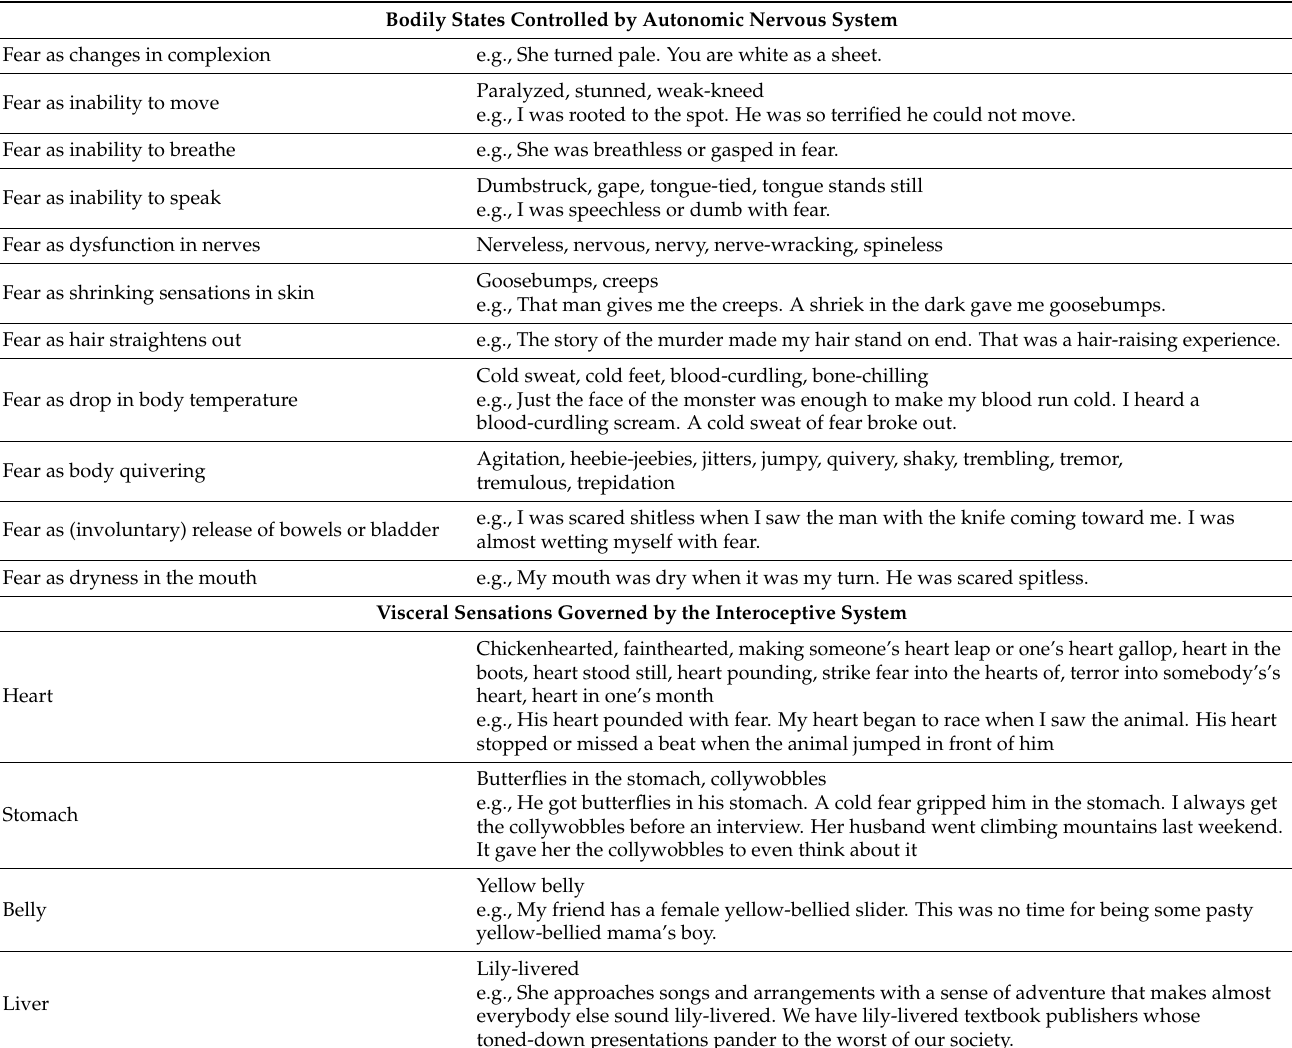
Table 2. English embodied words describing fear or fearful bodily